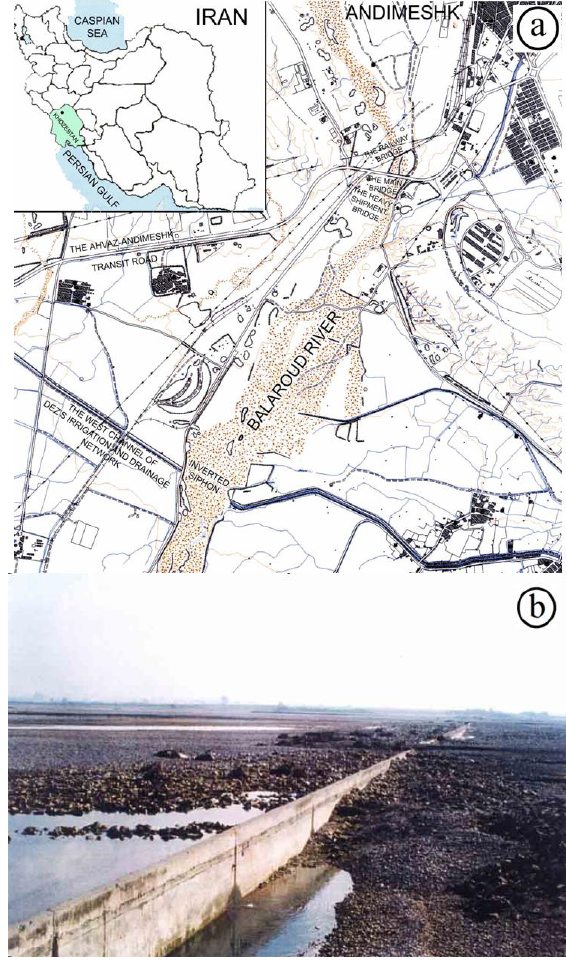
Figure 1. a) Location of studied area. b) Formation of grade-control structure in Balaroud river bed by protrusion of Balaroud inverted siphon structures located in Dez west irrigation system in SW of Iran.